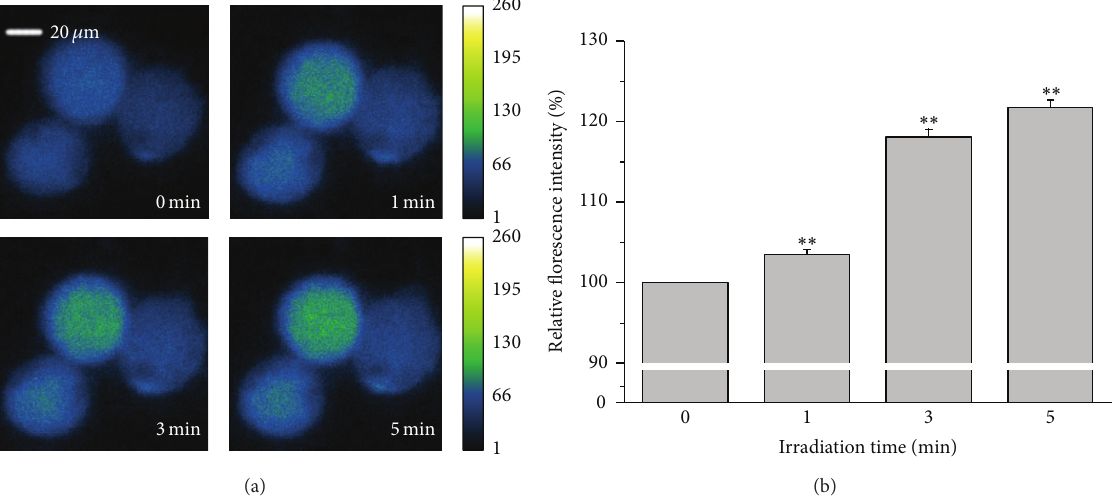
Figure 3: Response of [Ca 2+ ] i in HMC-1 cells induced by 657 nm and 0.28 W/cm 2 laser irradiation. (a) Representative MCs before and after irradiation. Irradiation times are given in the lower right corners. The pseudocolor calibration bar on the right illustrates [Ca 2+ ] i (in relative units). (b) Quantitative analysis from several sets of cells normalized to basal [Ca 2+ ] i -dependent fluorescence before irradiation (=100%). Prolongation of laser irradiation enhanced fluorescence intensity in HMC-1 cells. The data represent averages ± SEM from 𝑛 = 15 –17 cells. ∗∗ 𝑃 < 0.01 , compared to